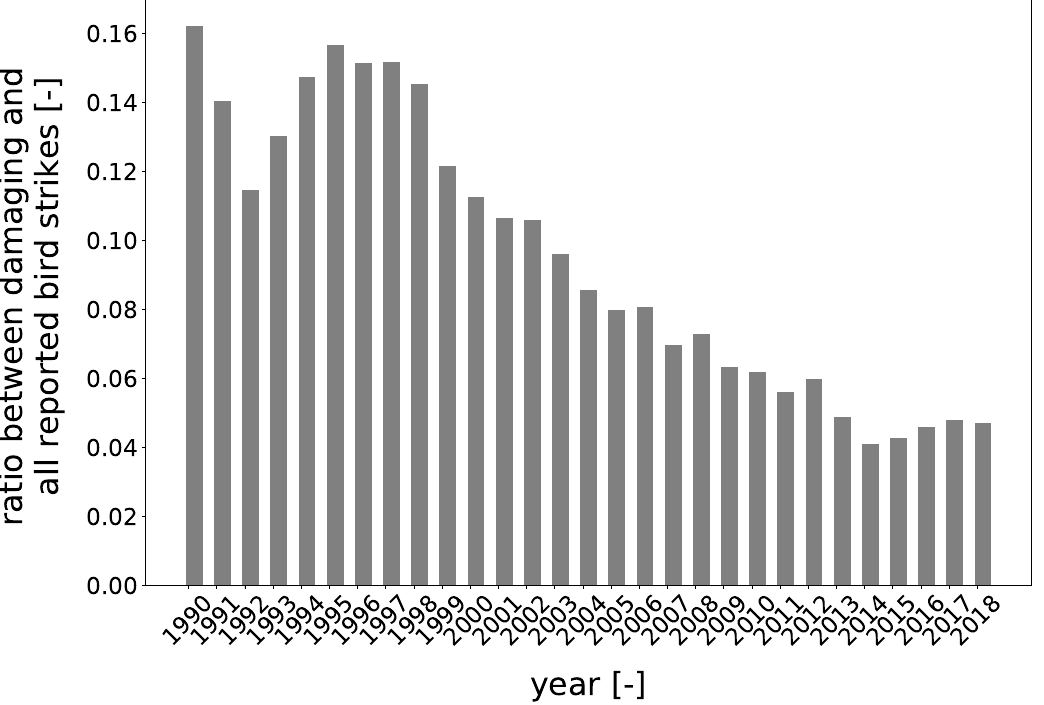
Figure 1. Ratio between damaging strikes and all strikes in the USA between 1990 and 2018. Source: